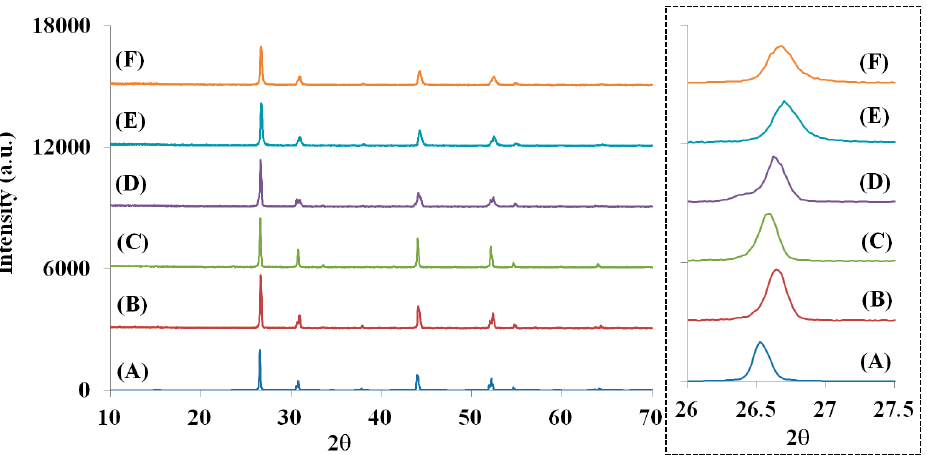
Figure 2. The calculated XRD patterns of (A) LaO 0.65 F 1.7 (ICSD 40371) and the obtained XRD patterns of La 1- p - q Bi p Eu q O 0.65 F 1.7 phosphors (B) p = 0.01 and q = 0, (C) p = 0.05 and q = 0, (D) p = 0 and q = 0.05, (E) p = 0 and q = 0.1, and (F) p = 0.01 and q = 0.1. Table 1. The unit-cell parameters with the cell volumes of the La 0.99 Bi 0.01 O 0.65 F 1.7 , La 0.95 Bi 0.05 O 0.65 F 1.7 ,